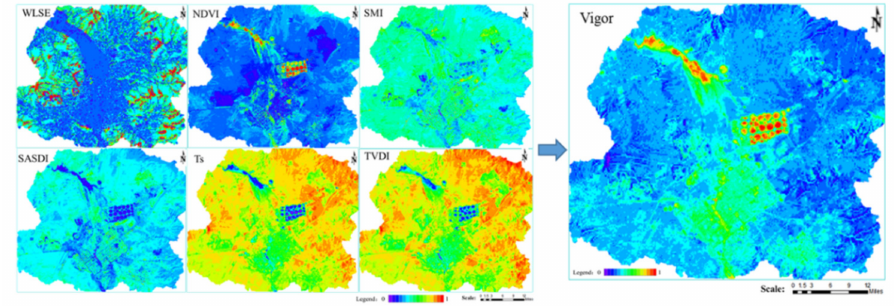
Figure 5. Spatial distribution of